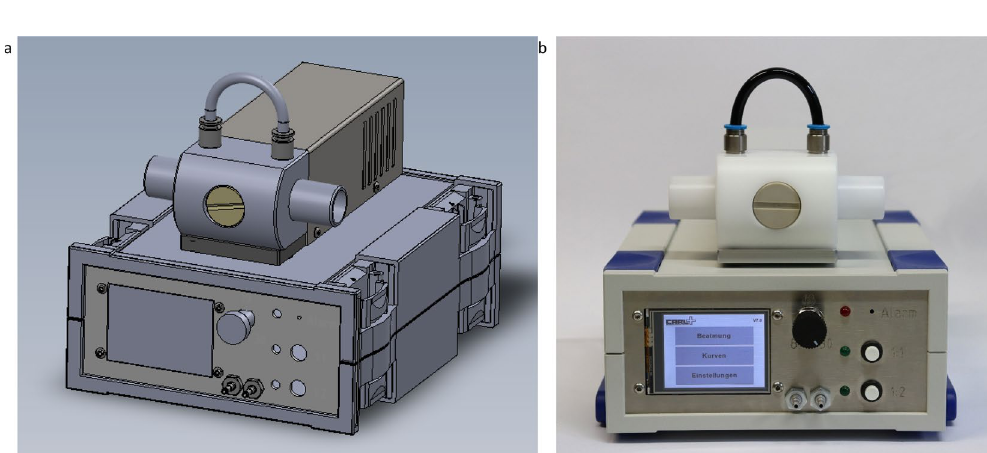
Figure 5. Illustrations of the module CARL. ( a ) 3D model of the module CARL. ( b ) Assembled model of